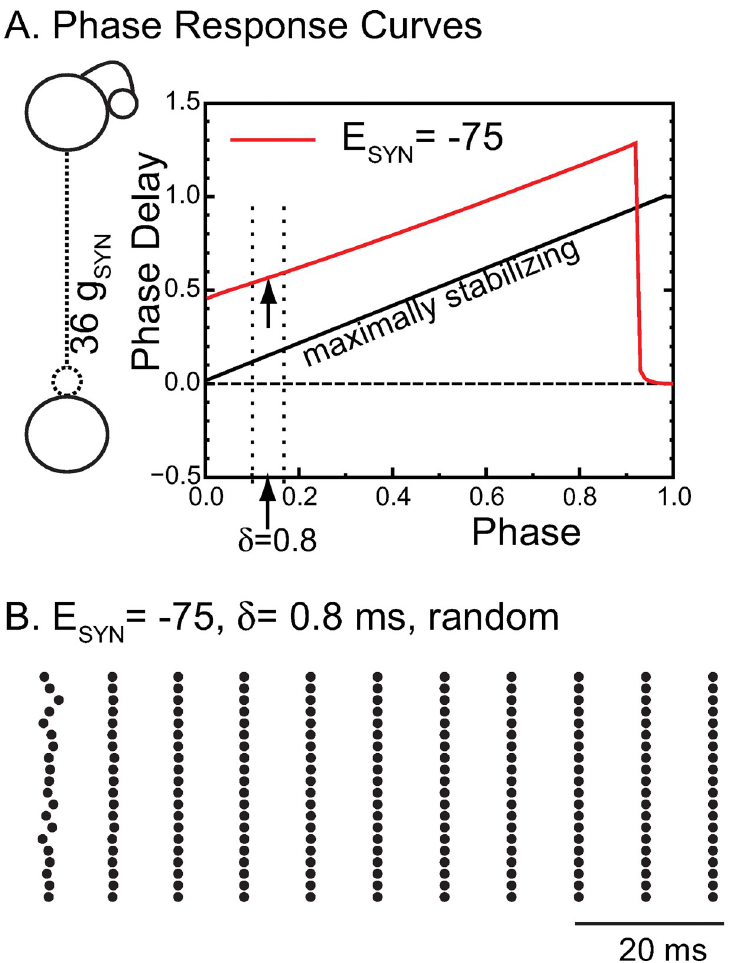
Fig 4. Phase Response Curve Explain Synchronizing Tendencies for Hyperpolarizing inhibition. A. A biexponential inhibitory postsynaptic conductance was used as the perturbation to a single neuron from Fig 3A1 to generate the PRC for hyperpolarizing (red). The strength of an individual conductance was multiplied by 36 to reflect the 36 simultaneous inputs received by a single neuron (left inset) during perfectly synchronous oscillations. The arrows indicate the phase at which an input delayed by 0.8 ms is received in the network. The dashed lines refer to the range of synaptic delays shown in Fig 3A3 and 3B3. The free running period of this neuron is 5.97 ms at a constant ChR conductance of 7 nS, the midpoint of the excitatory theta drive. B. For hyperpolarizing synapses with conduction delays of 0.8 ms, synchrony is stable and attracts from random initial conditions in a single cycle in this raster plot of 20 representative neurons from the 100 neuron